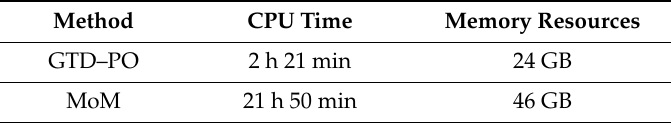
Table 1. Comparison of the CPU time and memory resources required for analysis of the monostatic RCS of the airplane mock-up in near-field conditions.